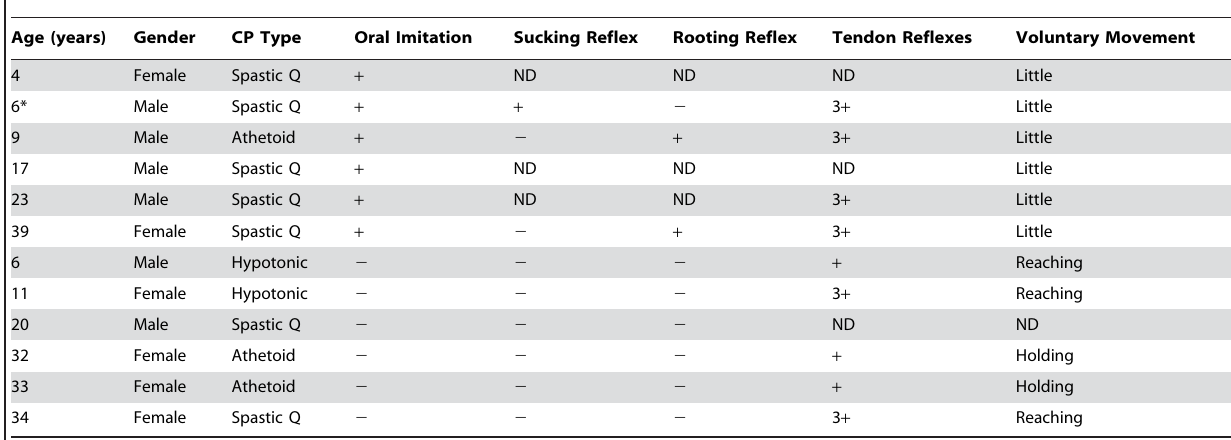
Table 1. Relationship between oral imitation, primitive reflexes, and residual voluntary movement in patients with cerebral palsy.